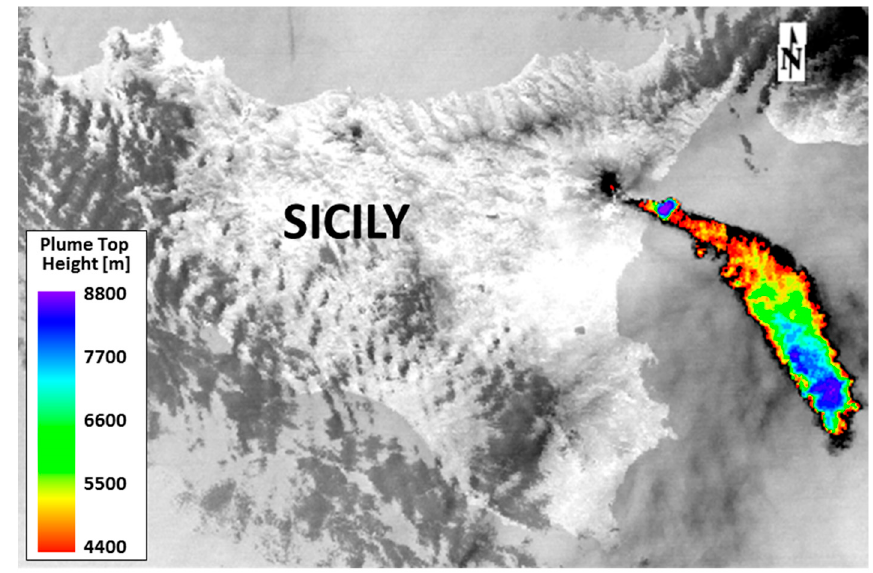
Figure 9. Plume top height derived from the VIIRS image acquired on 24 December 2018 at 12:46.